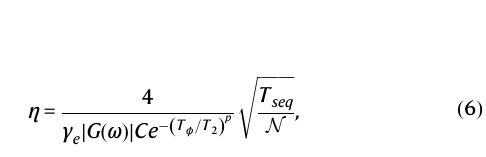
Fig. 1 | Phase-sensitive NV magnetometry. a Continuous sampling induced phase reviving signals, known as the quantum heterodyne (Q-dyne) detection. Field interaction time should be set in measurement sequences as τ 1 or τ 2 for different frequencies ofthesignals s 1 or s 2 . F k is the fl uorescence signal,where k denotesthenumberoftheoutputseriesnumber, R isthephotonrateand C is the contrast. G ( s ϕ , k ) is the sequence response to the fi eld s , which should be small to ensure the linearity. b Rotating frame modulation induced by the evolving phase difference of the two driving MW fi elds. The MWs acquire a phase difference as α − β = 2 πδ f Δ t after a sampling time interval Δ t due to the frequencyoffset δ f .ThepictureofBlochspheresshowstheprocessofrotating frame modulation, in which x 1 y 1 z is the rotating frame de fi ned by MW1, and y z is the rotating frame de fi ned by MW2. ϕ is the accumulated quantum x 2 2